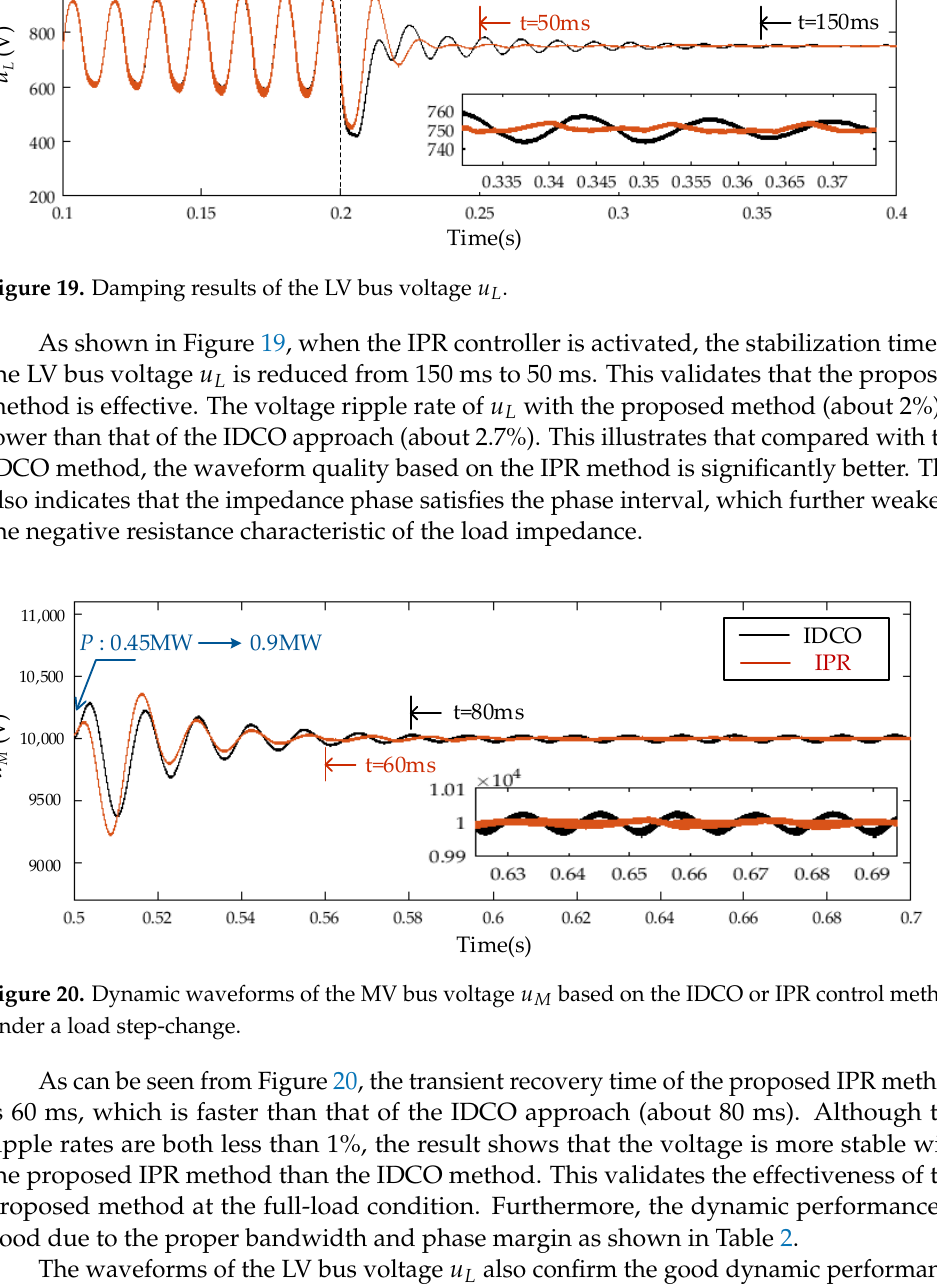
u based on the IDCO or IPR control M